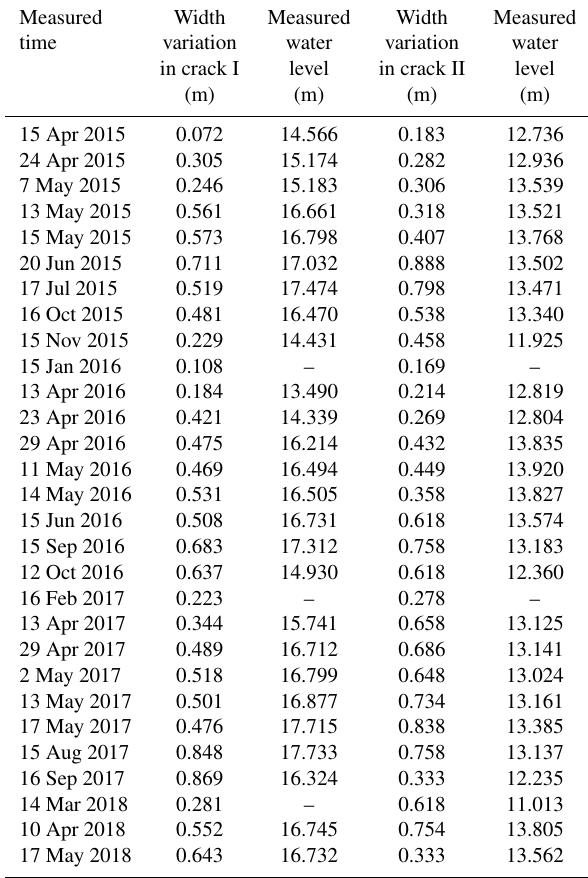
Table 3. The measured accumulated water-level data of the main bodies. Measured Width Measured